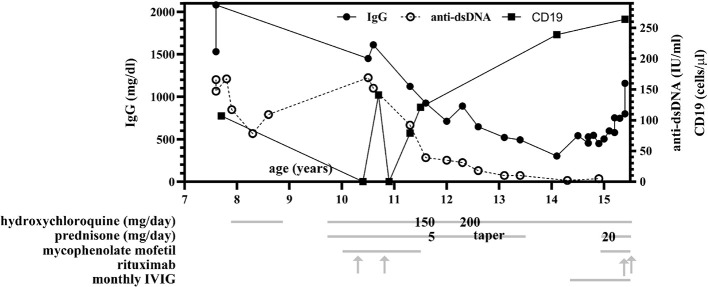
Total IgG and anti-dsDNA levels over time and compared to treatment regimen. Between ages 11 and 14, progressive hypogammaglobulinemia was observed and persisted despite discontinuation of mycophenolate mofetil (MMF) and rituximab infusions, with normalization of IgG levels at age 15 following monthly intravenous immunoglobulin (IVIG) infusions. Anti-dsDNA antibody levels decreased to within normal range (<10 IU/ml) following immunosuppressive therapy initiation at age 10. Treatment with hydroxychloroquine (HCQ), prednisone, MMF, rituximab, and IVIG are indicated by grey lines, and when specific dosing was identified by chart review, is additionally overlaid on the gray line at the time of therapy initiation or dosing change. MMF is twice daily dosing (BID) and was initiated at 500 mg per dose and increased to 1,000 mg twice daily at age 15. At age 10, she received two doses of 500 mg rituximab; at age 15, she received two doses of 1000 mg rituximab.